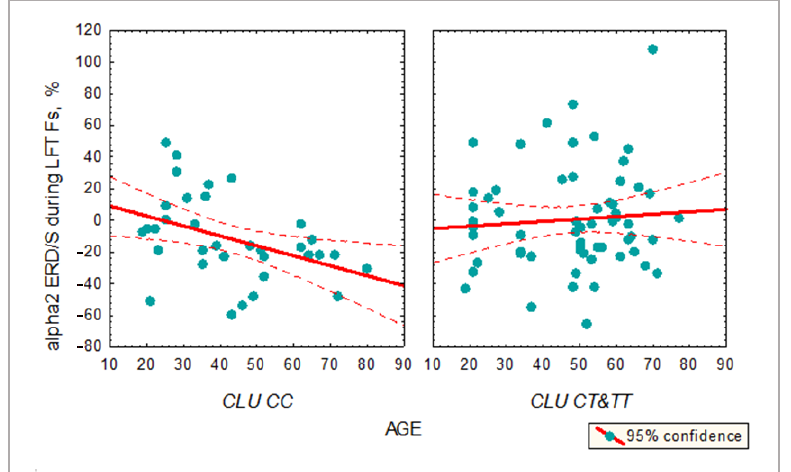
Figure 3. Correlation between age and alpha2 desynchronization during LFT in subjects with CLU CC and CLU CT&TT genotypes.